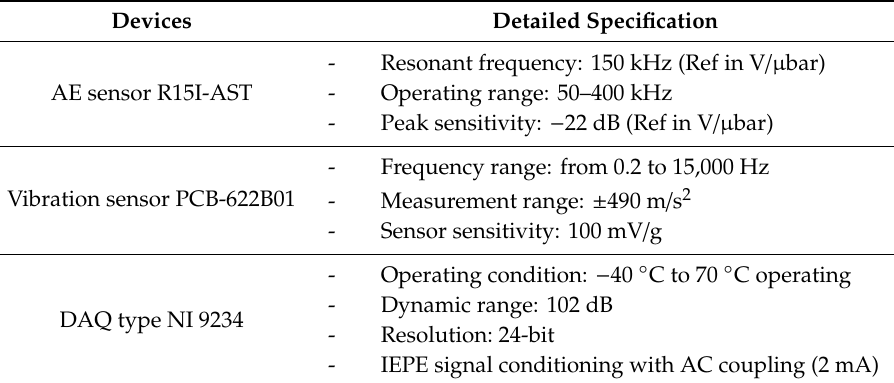
Table 1. Specifications of measuring sensors and data acquisition